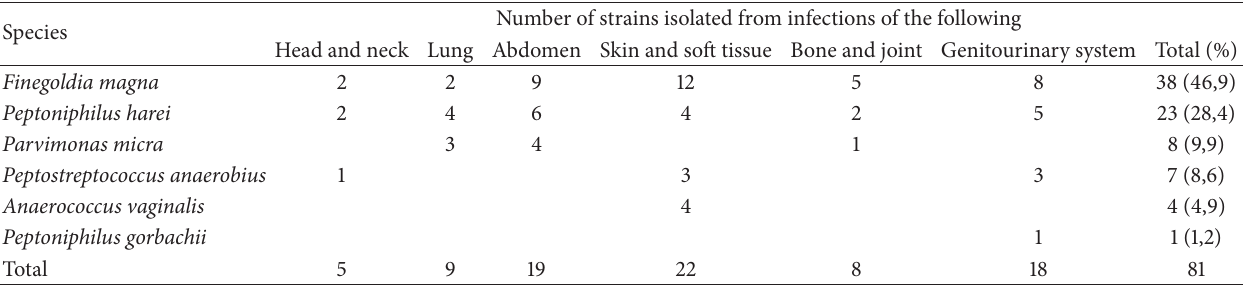
Table 1: Distribution and source of isolation of different species of GPAC between 2004 and 2014. Number of strains isolated from infections of the following Species Head and neck Lung Abdomen Skin and soft tissue Bone and joint Genitourinary system Total (%) Finegoldia magna